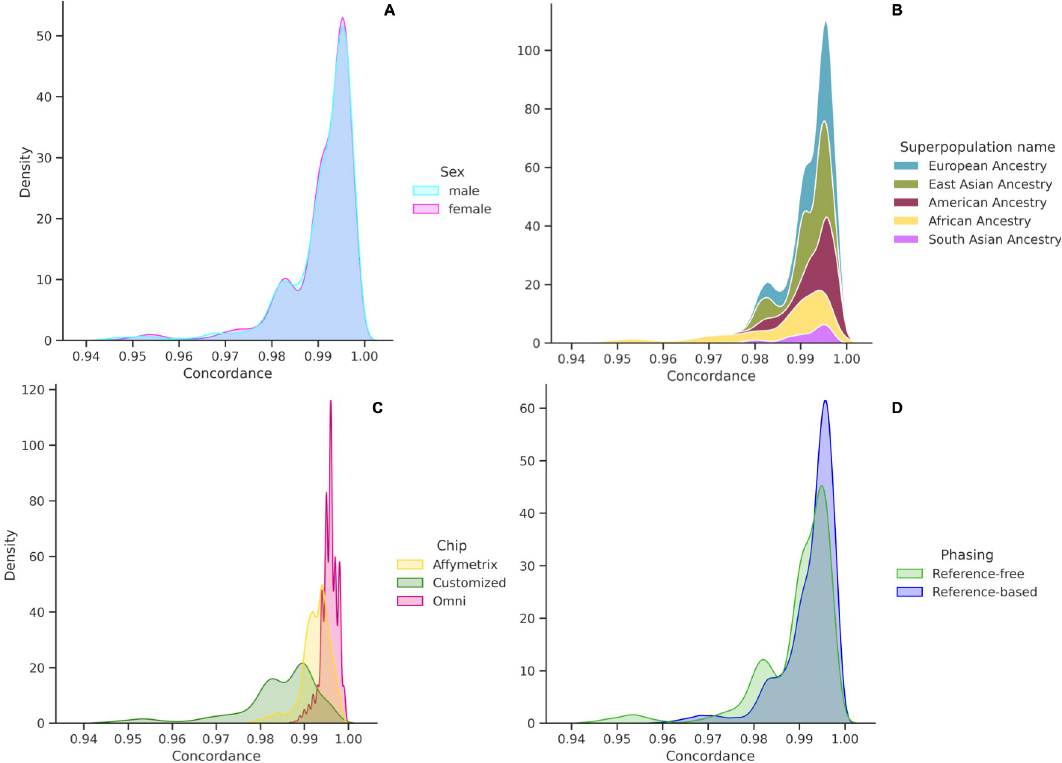
Fig 12. Imputation concordance rate over four different features. Stacked density plot of accuracy stratified by (A) sex; (B) superpopulation; (C) chip data; (D) phasing type (reference-free and reference-based).